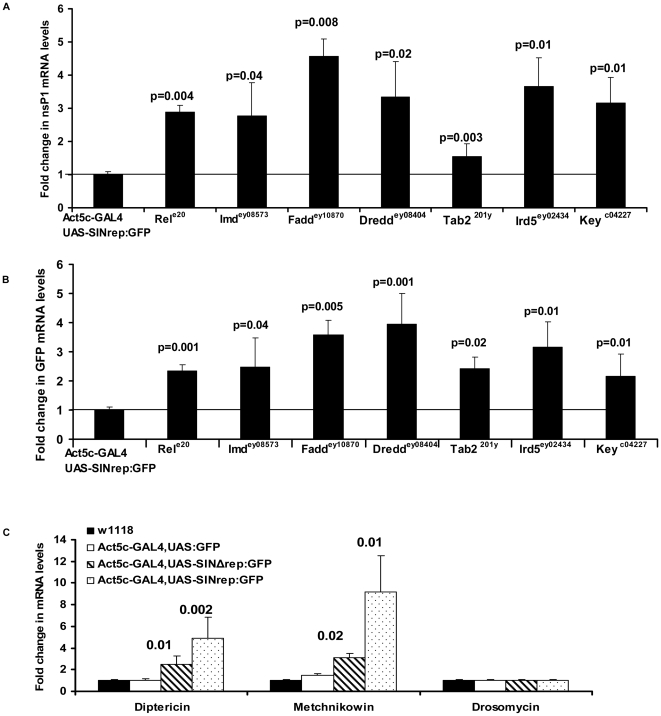
The Imd pathway is involved in controlling alphaviral replication.SIN replication was measured by real-time qRT-PCR analysis of nsP1 (A) and GFP (B) mRNAs in control SIN replicon flies and flies heterozygous for SIN replicon and relish (rele20), imd (imd ey08573), dfadd (BG4EY10870), dredd (dreddEY08404), tab2 (tab2 201y), ird5 (ird5EY02434) and kenny (keyc02831) mutations. The value obtained for control SIN replicon flies was considered as one. (C) The expression of Diptericin, Metchnikowin and Drosomycin AMPs was measured in w1118 flies, GFP expressing flies, mutant SIN replicon expressing flies, and SIN replicon expressing flies by real-time qRT-PCR. The value obtained for w1118 flies was considered as one. Data shown is representative of three independent experiments. Error bars represent SD.